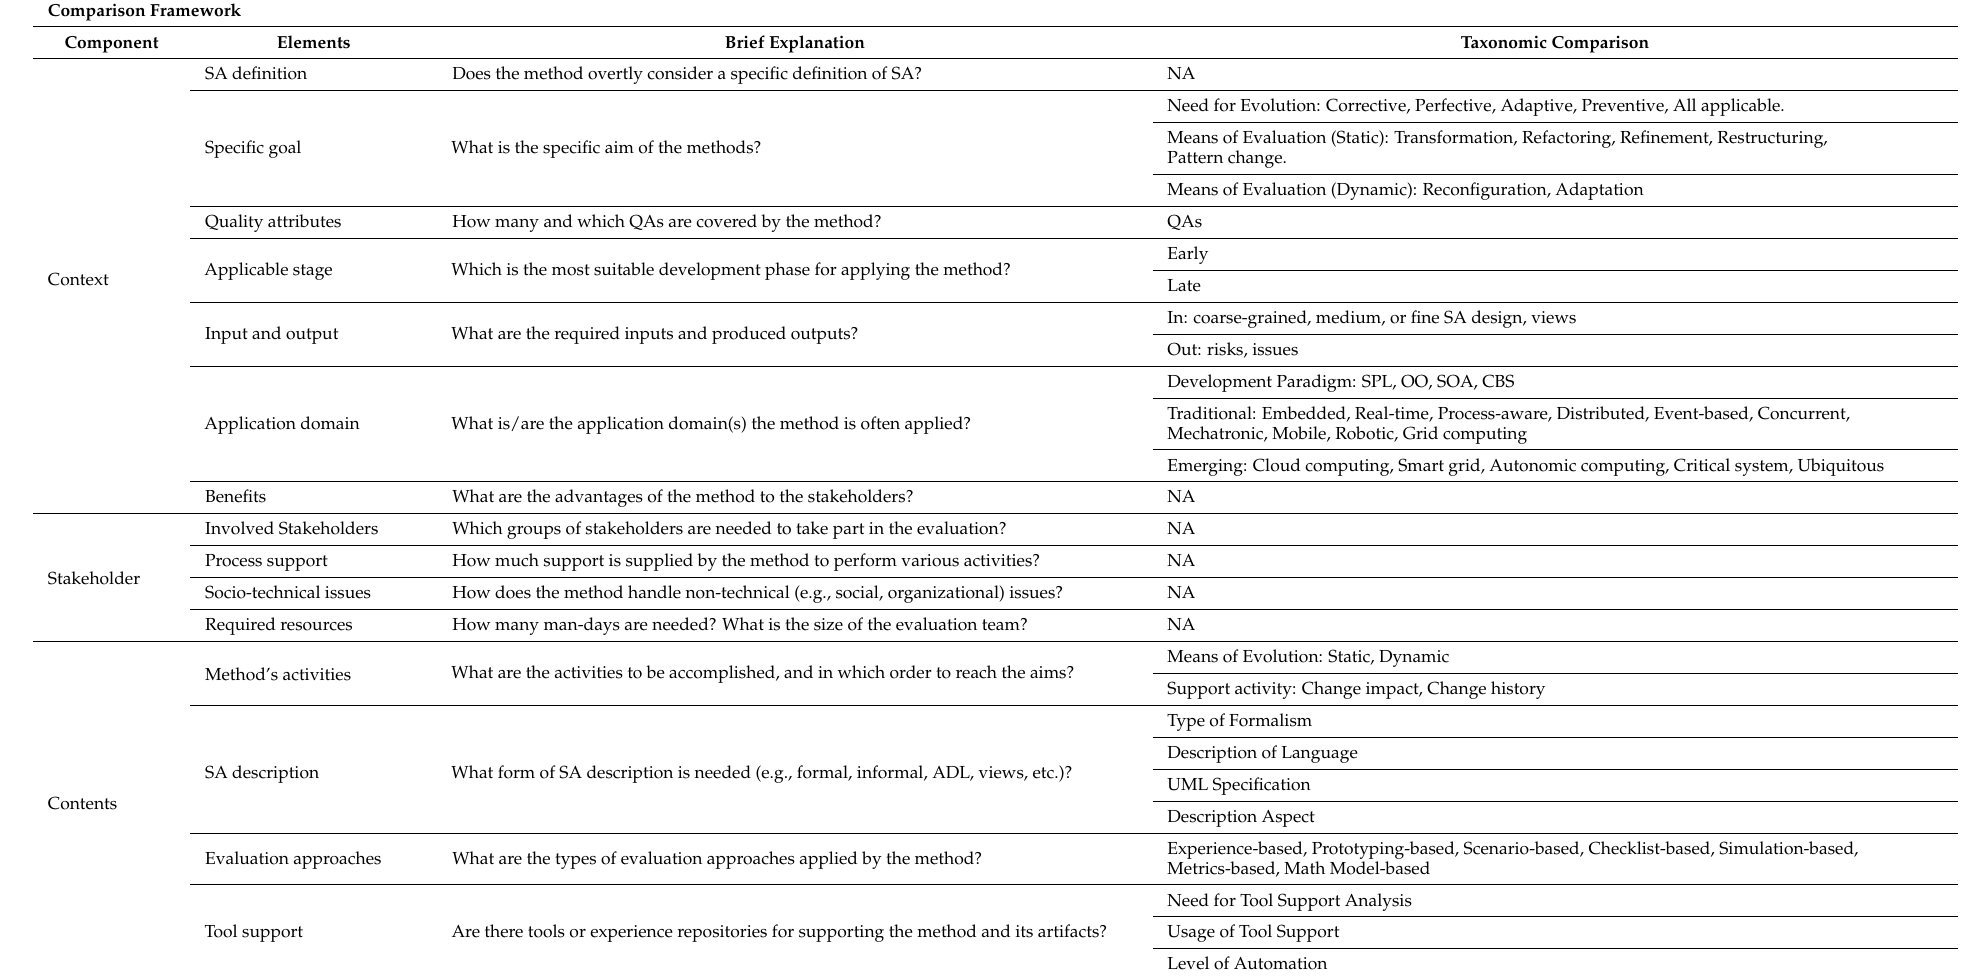
Table 3. Software evaluations comparison